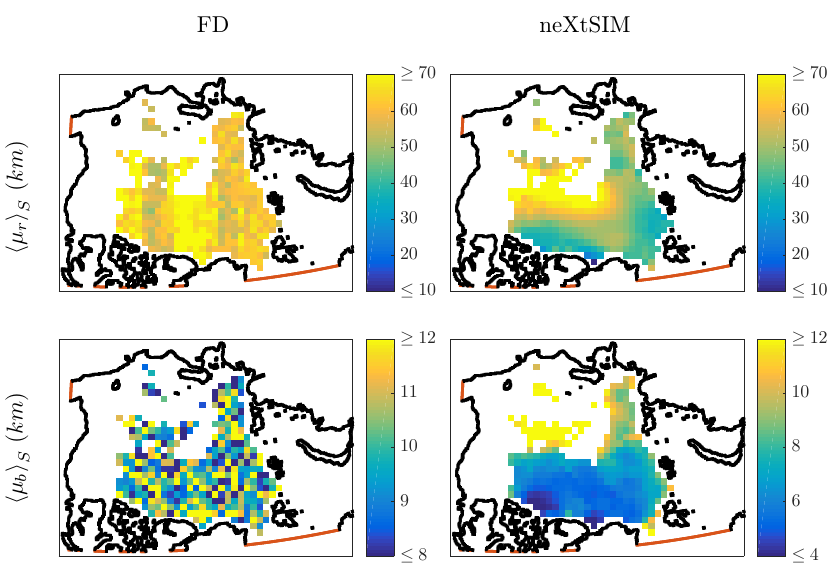
Figure 8. Mean over the summer period of µ r (t) and µ b (t) at t = 10 days. The calculated values are represented by coloured squares centred on the summer starting points x 0 (not shown).